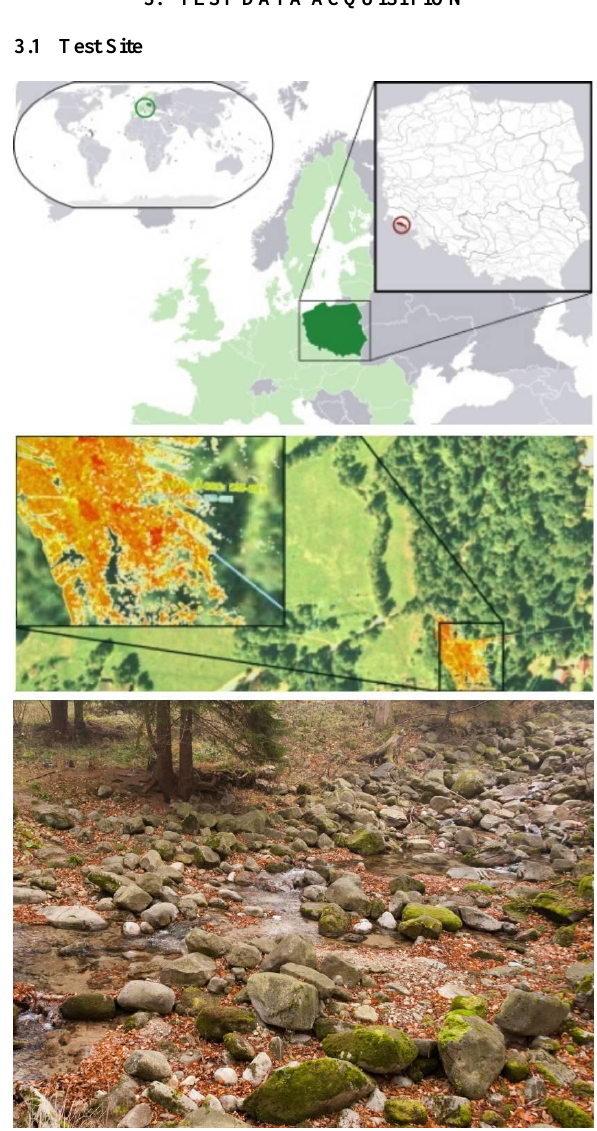
Figure 4. Test site location